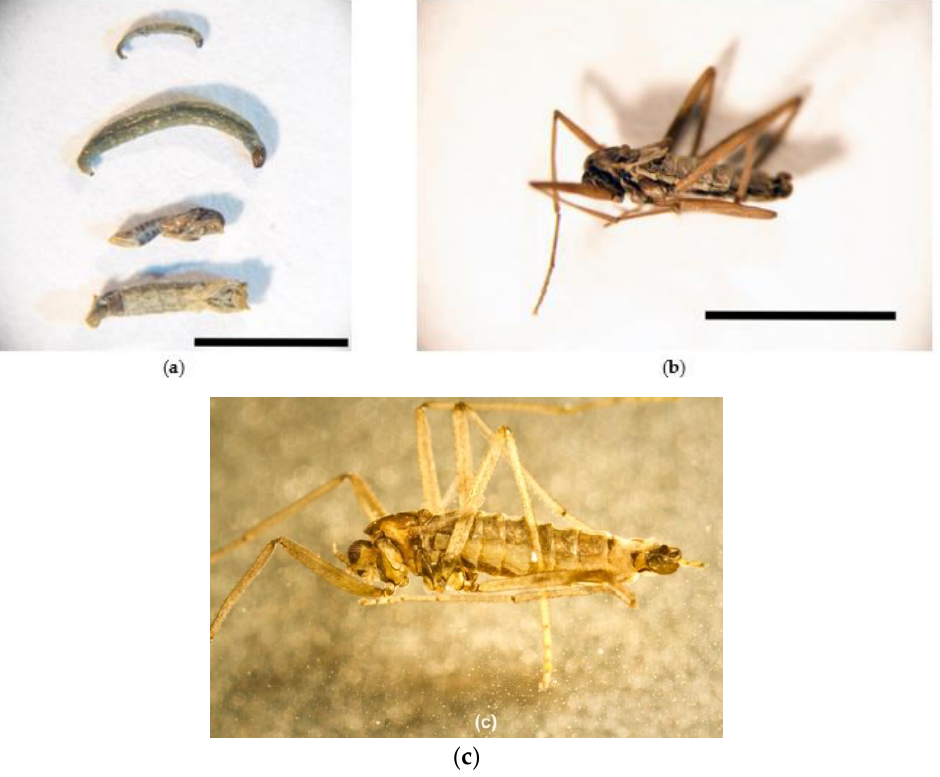
Figure 1. Specimens of Telmatogeton magellanicus : ( a ) Two larvae (2nd and 4th instars) and two pupae (one larger female and one smaller male); ( b,c ) Adult females (( c ) by Gonzalo Arriagada). Scale bar = 0.5 cm.